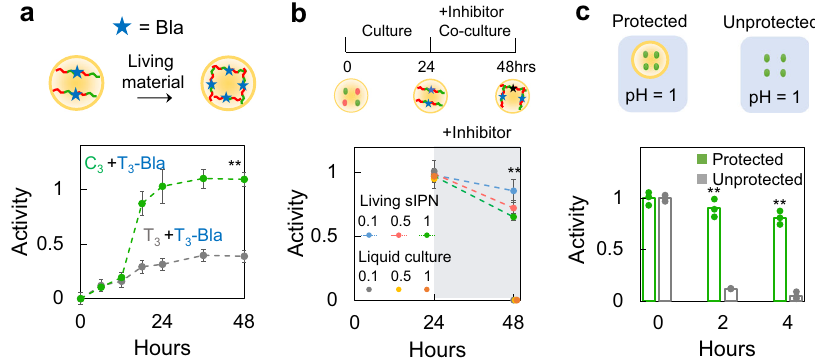
Fig. 3 Living sIPN enhanced or stabilized anchored functions. a sIPN formation enhanced the activity of the anchored enzyme (Bla) over time (top: schematic; bottom: experimental data). MC(T 3 -Bla) and MC(C 3 ) bacteria were mixed, encapsulated with chitosan, and cultured in M9 for 48 h. As a control, MC (C 3 ) was replaced with MC (T 3 ). The capsules were harvested at different time points and washed by PBS before enzymatic assay. The y -axis indicates the Bla activity in the unit of OD 490 /h. The experiments were done in triplicate. At 48 h, the activity from sIPN capsules was ~2.8 times that of non-IPN capsules (** p < 0.01 ( p = 0.0002), determined by the two-sided Student ’ s two-sample t -test assuming unequal variances; error bars = standard deviation ( n = 3)). b Living sIPN capsules maintained enzymatic activity under sustained perturbation (top: schematic; bottom: experimental data). Cells (MC(T 3 -Bla)) and cells (MC(C 3 )) were mixed and inoculated into M9 (liquid culture), or encapsulated with chitosan (living sIPN capsules) and cultured in the same amount of M9 for 24 h. The samples (the supernatant containing Bla for the liquid culture, and the capsules for living sIPN capsules) were collected and sent for Bla enzymatic assay. Then, the clavulanic acid (0.1, 0.5, or 1 μ g/mL) was added to the liquid culture, or living sIPN capsules for another 24 h (shaded area) before the Bla enzymatic assay. The data were normalized by the control (liquid culture or living sIPN capsules not treated by clavulanic acid). The experiments were done in triplicate. At 48 h, the enzymatic activity of living sIPN capsules was signi fi cantly greater than that of the liquid culture, which was close to be zero (** p < 0.01 ( p = 0.004, 0.003 and 0.001 for 0.1, 0.5, or 1 μ g/mL clavulanic acid concentration), determined